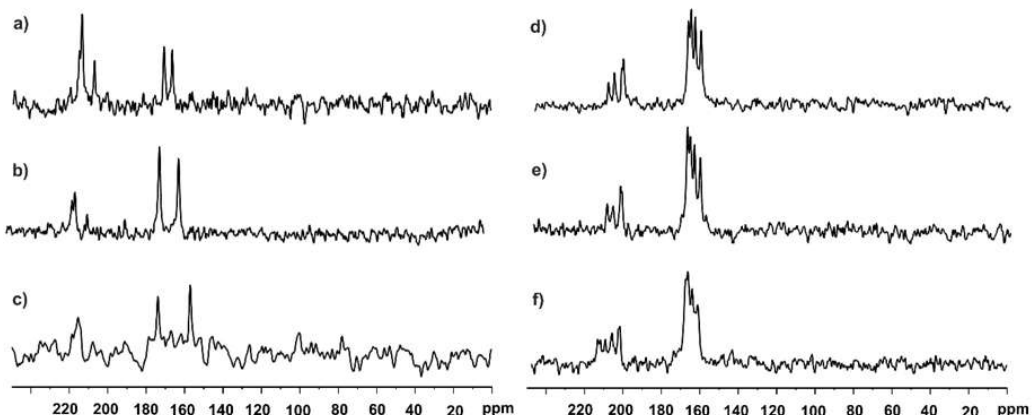
Figure 5. The 60.82 MHz 15 N CP / MAS spectra recorded with a spinning rate of 11 or 12 kHz. The left column shows a physical mixture of HIMO and TBA in a ratio of 1:1, ( a ) HIMO and TBA crystallized from MeCN (tautomer A); ( b ) HIMO and TBA crystallized from EtOH (tautomer B); ( c ) HIMO and TBA crystallized from water (tautomer B). The right column displays the spectra of samples after 1 h of grinding with MeOH as a LAG; ( d ) HIMO and TBA crystallized from MeCN; ( e ) HIMO and TBA crystallized from EtOH; ( f ) HIMO and TBA crystallized from water.